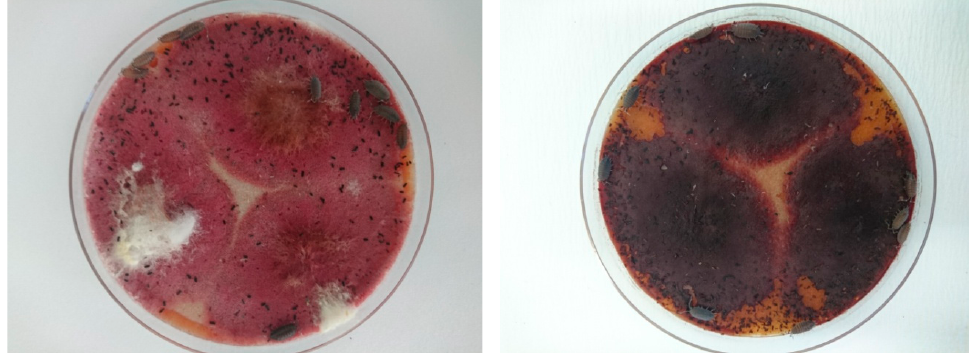
Figure 2. Fusarium solani mycelial loss in two weeks (Photo: Nóra Balázs, Gödöll ő , Hungary, 2016).